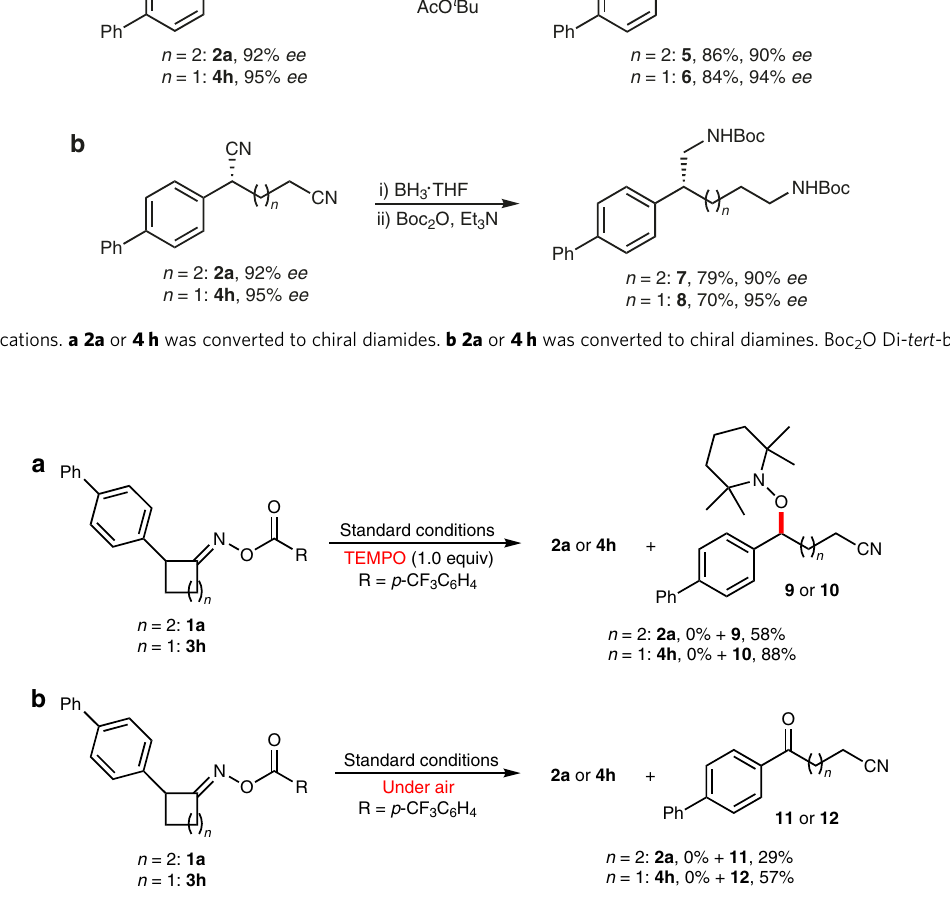
Fig. 5 Preliminary mechanistic studies. a Radical trapping experiment with TEMPO. b Radical trapping experiment with O 2 . TEMPO 2,2,6,6-